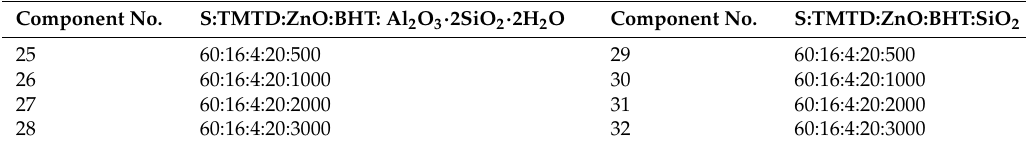
Table 6. The composition with kaolin or carbon-white stabilizer.